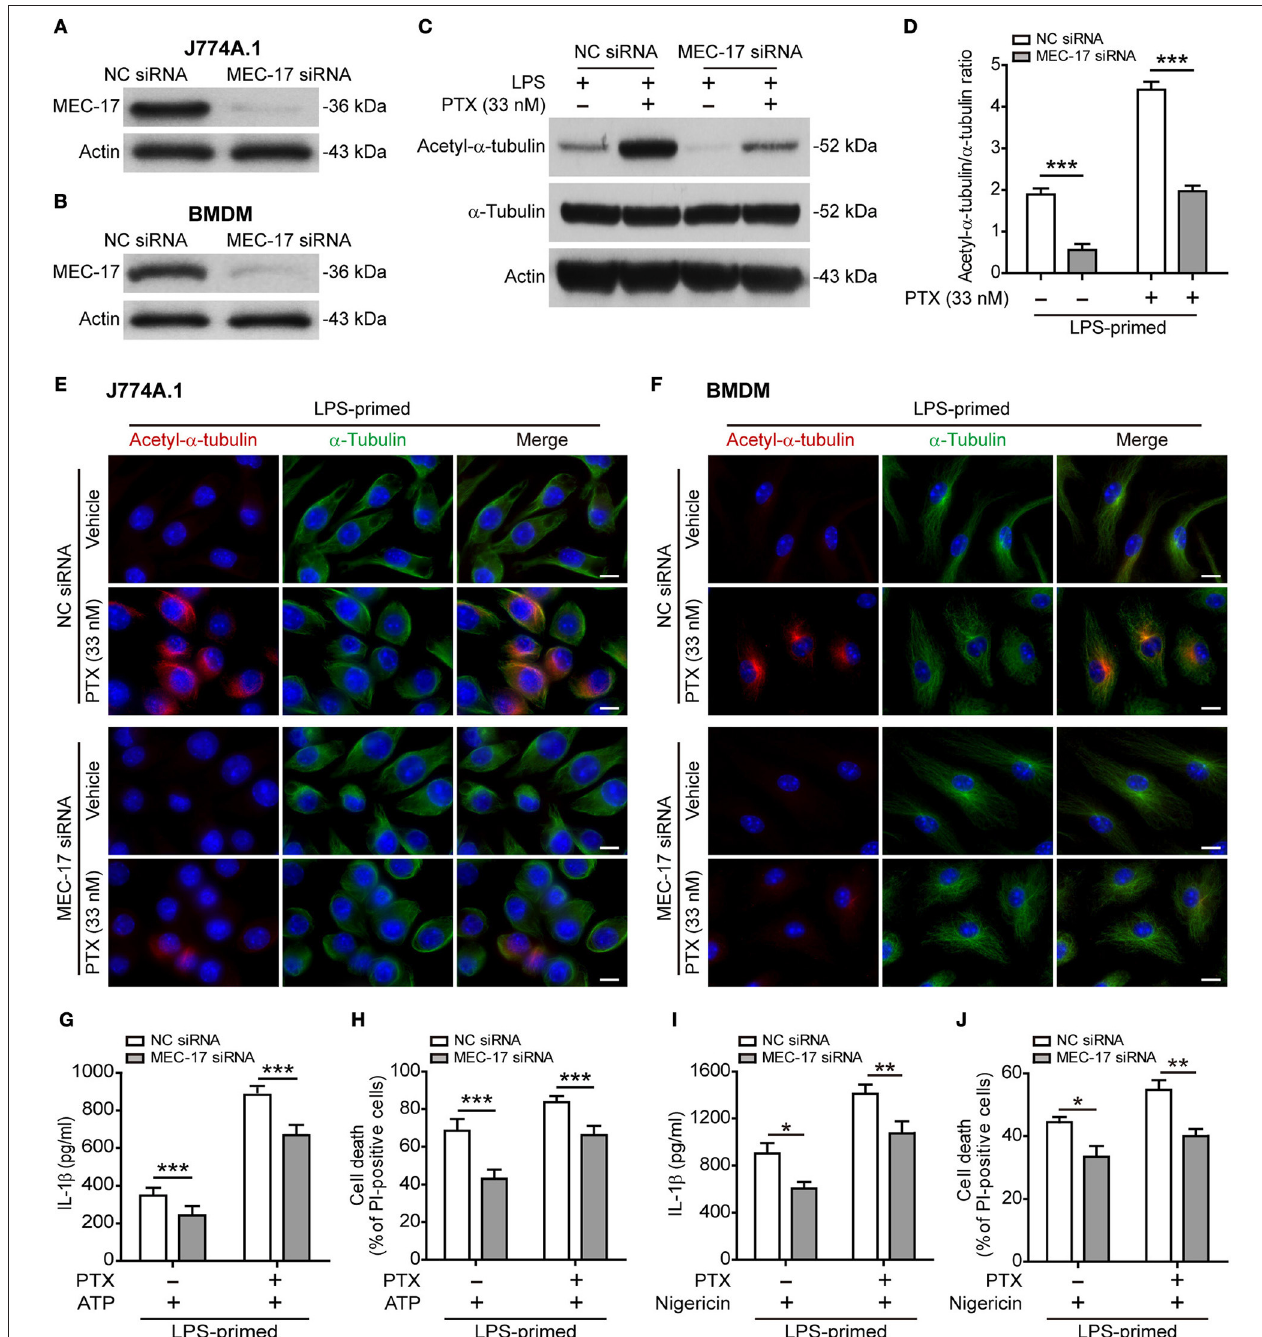
FIGURE 6 | MEC-17 knockdown attenuated paclitaxel-mediated augmentation of NLRP3 inflammasome activation and pyroptosis. J774A.1 macrophages and BMDMs were transfected with negative control (NC) siRNA or MEC-17 siRNA for 72h and were used for the following experiments. (A,B) The levels of MEC-17 expression in J774A.1 (A) or BMDMs (B) were detected by Western blotting. (C–F) LPS-primed J774A.1 macrophages were treated with paclitaxel (33nM) for 1h. The expression of acetylated α -tubulin and α -tubulin were revealed by Western blotting (C) and the relative gray values of acetylated α -tubulin to α -tubulin were quantified (D) . Data are shown as mean ± SD ( n = 3). Immunofluorescence microscopy revealed the expression of acetylated α -tubulin (red) and α -tubulin (green) in J774A.1 cells (E) or in BMDMs (F) . Nuclei were stained with Hoechst 33342 (blue). Scale bars, 10 µ m. (G–J) Cells were primed with LPS (500ng/ml for 4h) before treated with paclitaxel (33nM) for 1h, followed by incubation with ATP (3mM for 1h) in J774A.1 (G,H) or nigericin (5 µ M for 1h) in BMDMs (I,J) . The levels of soluble IL-1 β were detected by cytometric bead array (G,I) . Cell death was measured by staining with propidium iodide (PI) and Hoechst 33342 together for 10min. PI-positive cells were quantified by counting 5 randomly chosen fields (one field per well) containing around 100 cells each (H,J) . Data were analyzed using the unpaired Student’s t -test, which are shown as mean ± SD ( n = 5). * P < 0.05; ** P < 0.01; *** P < 0.001. PTX, paclitaxel.